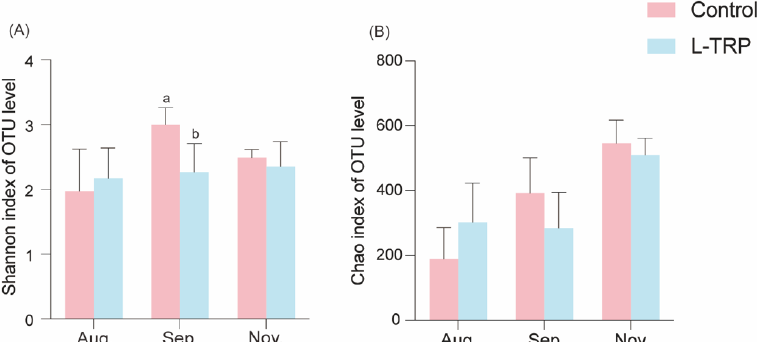
Figure 5. Alpha diversity analysis of biodiversity: Shannon ( A ) and Chao1 ( B ) richness and diversity index of each group (n = 5). Different letters above the column represent the significant differences between the control and L-TRP groups ( p < 0.05).